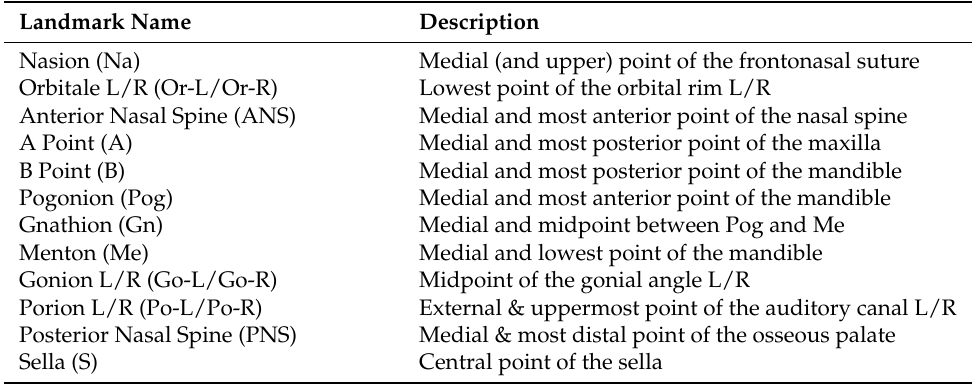
Table 1. Definition of “conventional” landmarks localized in our study (L/R: Left/Right). Table 2. Definition of “foraminal” landmarks localized in our study (L/R: Left/Right).